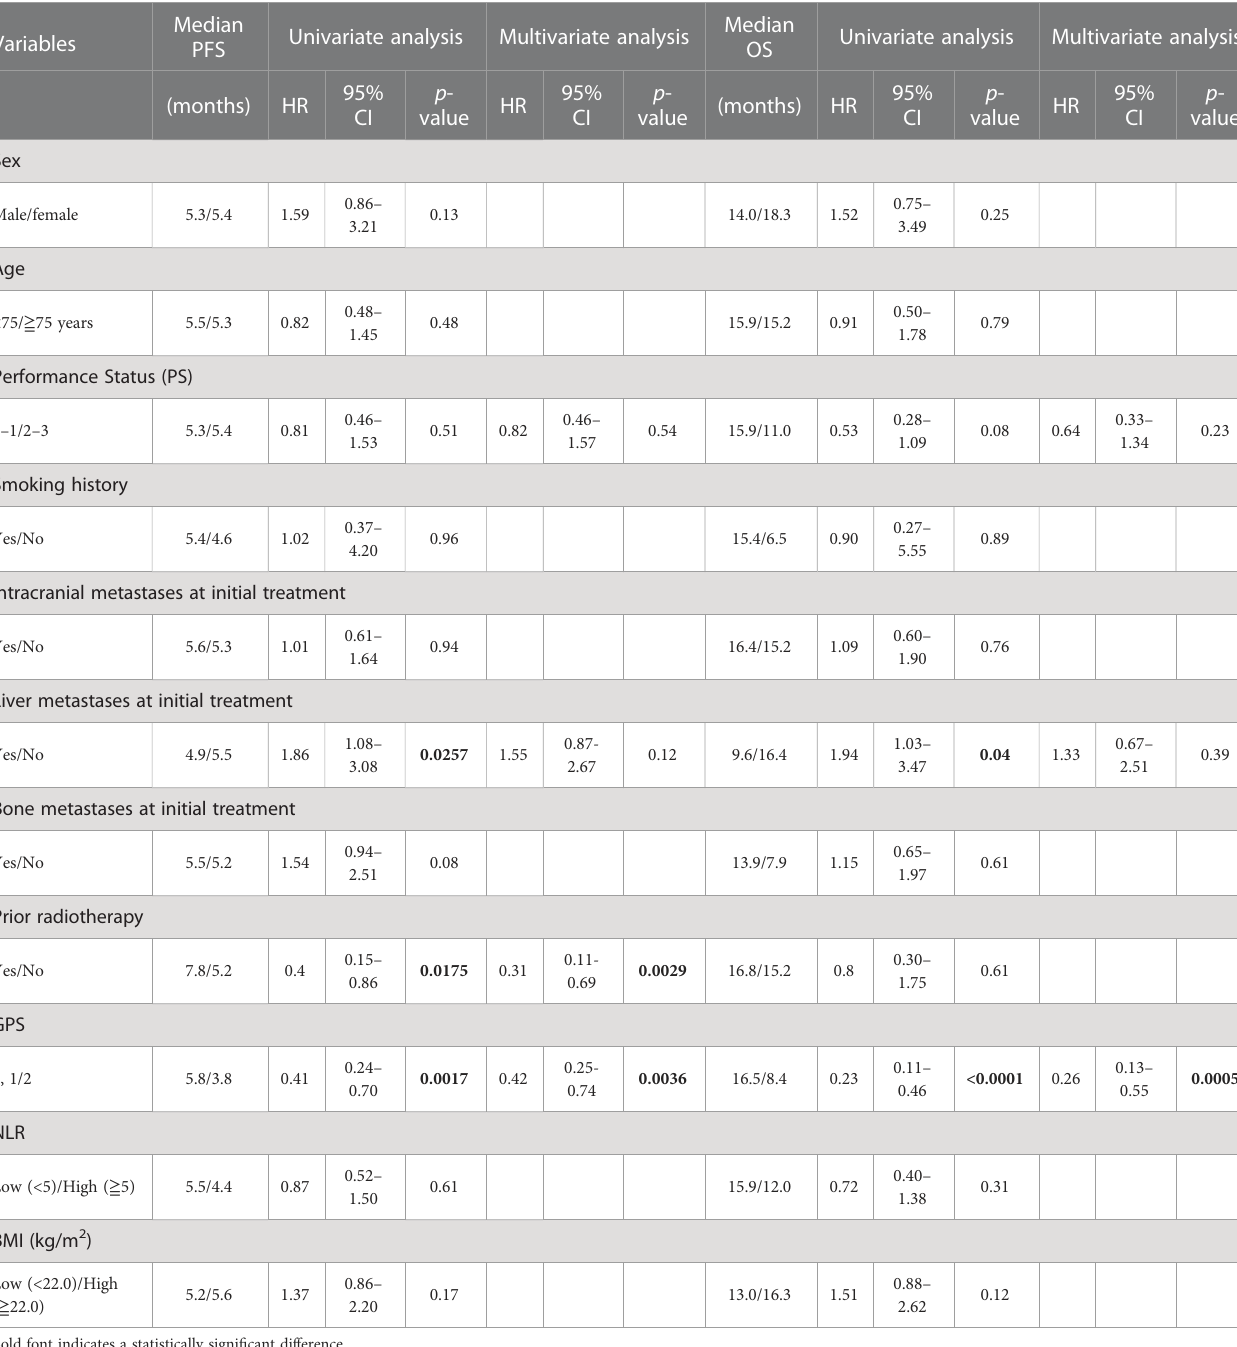
Median Univariate analysis Multivariate OS